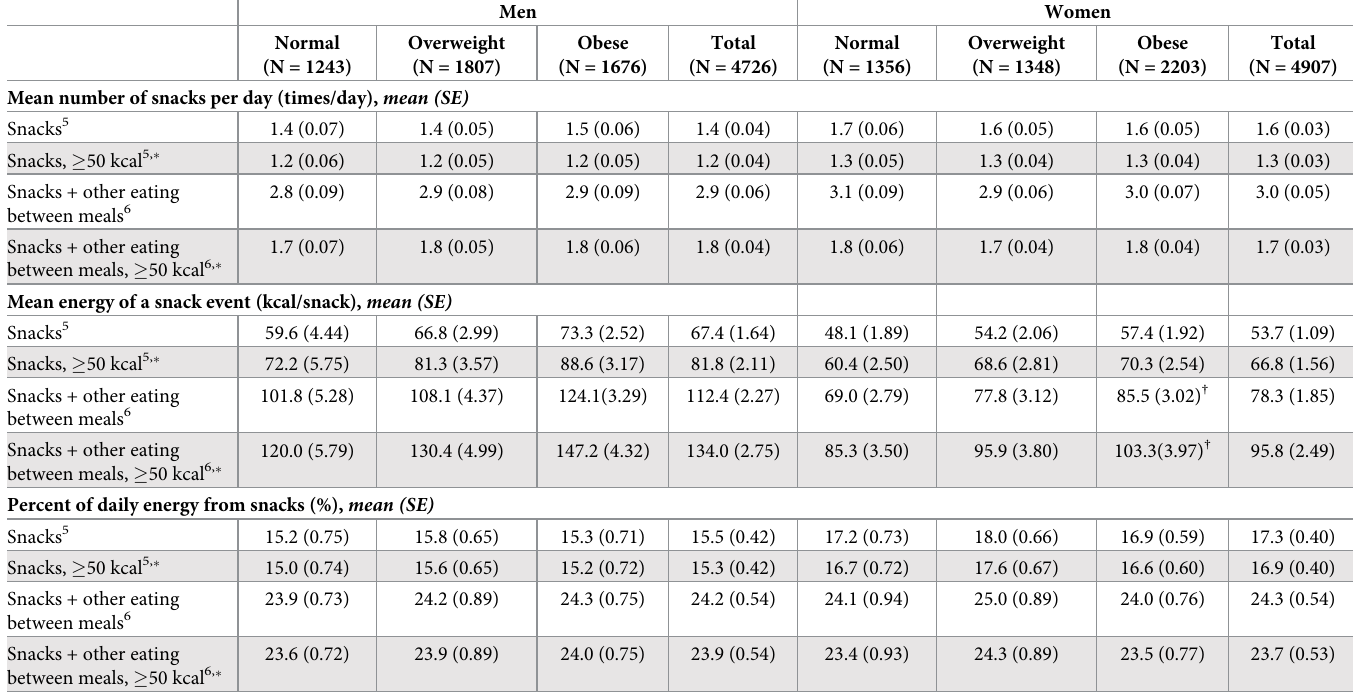
Table 3. Snacking frequency and energy contributed by snack by Body Mass Index (BMI) category among U.S. adults ( � 20y), NHANES 2013–2016 1-4